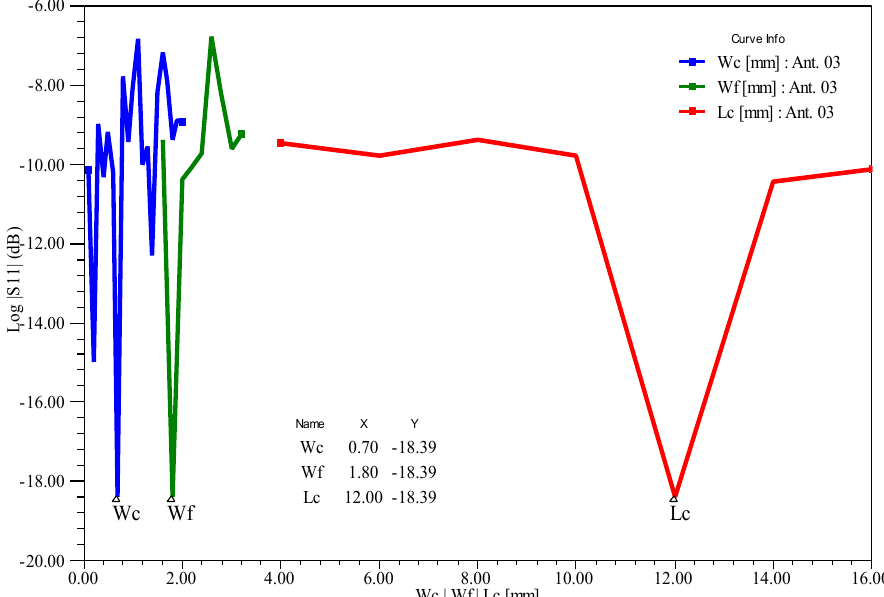
Figure 10. Reflection coefficient of Slot antenna 3 at 2450 MHz versus Wc, Wf, and Lc (mm).